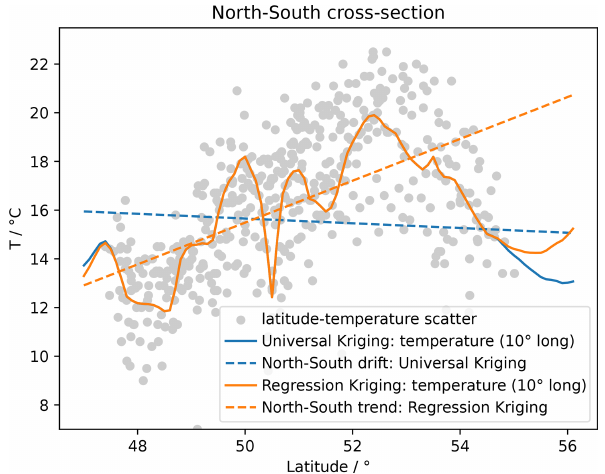
Figure 21. Scatterplot of latitude–temperature values (grey dots), the linear regression result (dashed orange line), universal kriging mean drift (dashed blue line) and the cross-sections of the respective kriging interpolation (solid